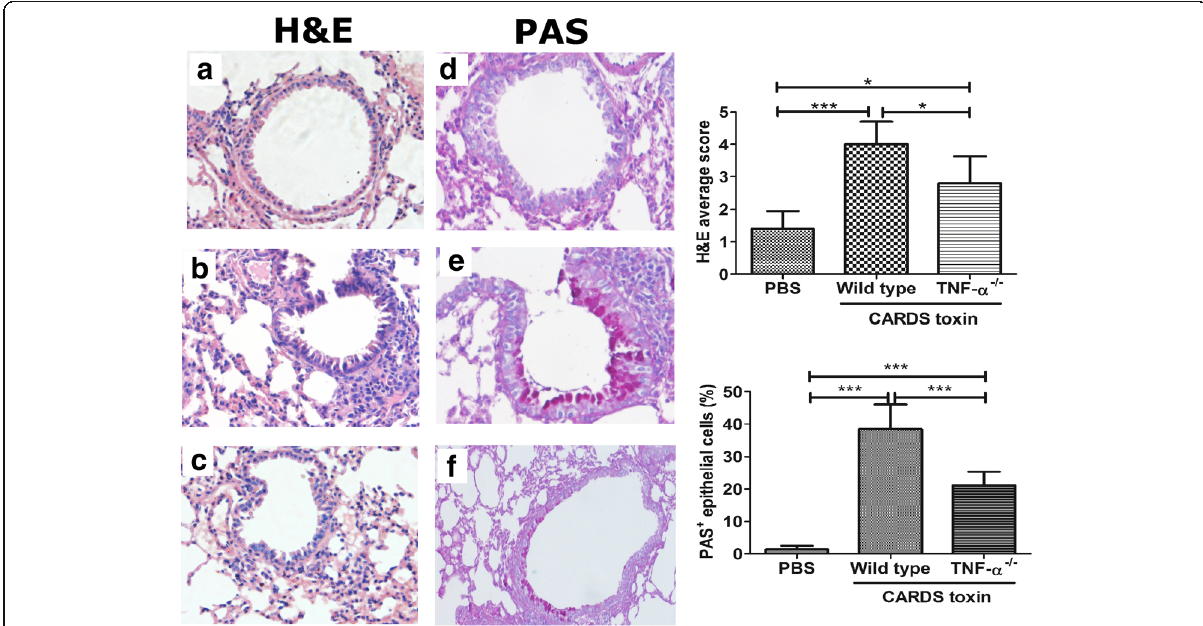
Fig. 6 Effect of CARDS toxin on inflammatory cell infiltration and mucus secretion in mouse lungs. Following intranasal instillation of CARDS toxin (50 μ g/ 0.5mL) or equivalent PBS, the mouse lung tissues were harvested for heamatoxylin and eosin (H&E) staining and Periodic acid-Schiff (PAS) staining on the 7th day. Ten bronchial tubes with an inner diameter of 150 – 200 μ m were randomly selected from each section under a light microscope. H&E average score and the percentage of PAS-positive (PAS + ) epithelial cells in the total number of epithelial cells were analyzed by a pathologist in a blinded fashion. N=5/group. * p <0.05, *** p <0.001. a H&E staining in PBS controls; b H&E staining in CARDS toxin groups; c H&E staining in TNF- α -/- mice stimulated with CARDS toxin; d PAS staining in PBS controls; e PAS staining in CARDS toxin groups; f PAS staining in TNF- α -/- mice stimulated with CARDS